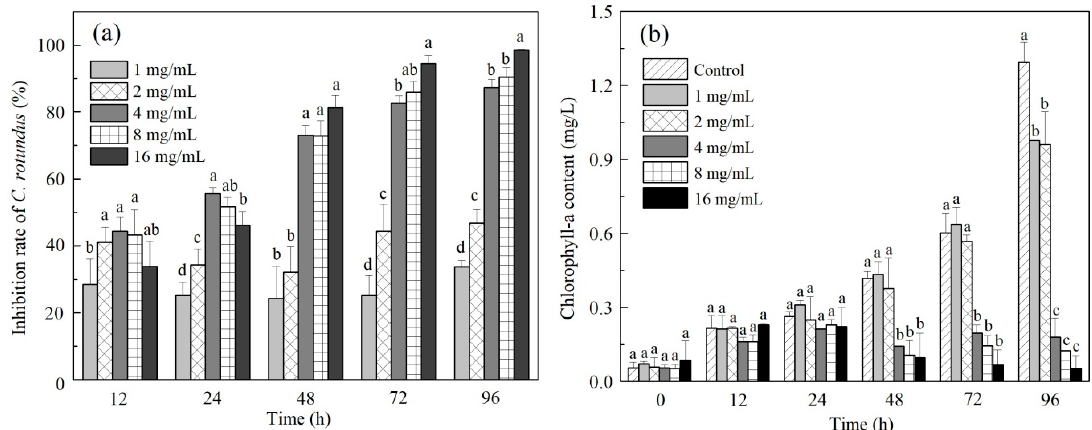
Figure 1. Inhibitory effect of C. rotundus aqueous extracts on P. globosa growth ( a ) and chlorophyll-a content ( b ). The data are presented as mean ± standard deviation ( n = 4). Different letters indicated statistically significant differences among different groups at the same experimental time ( p < 0.05).